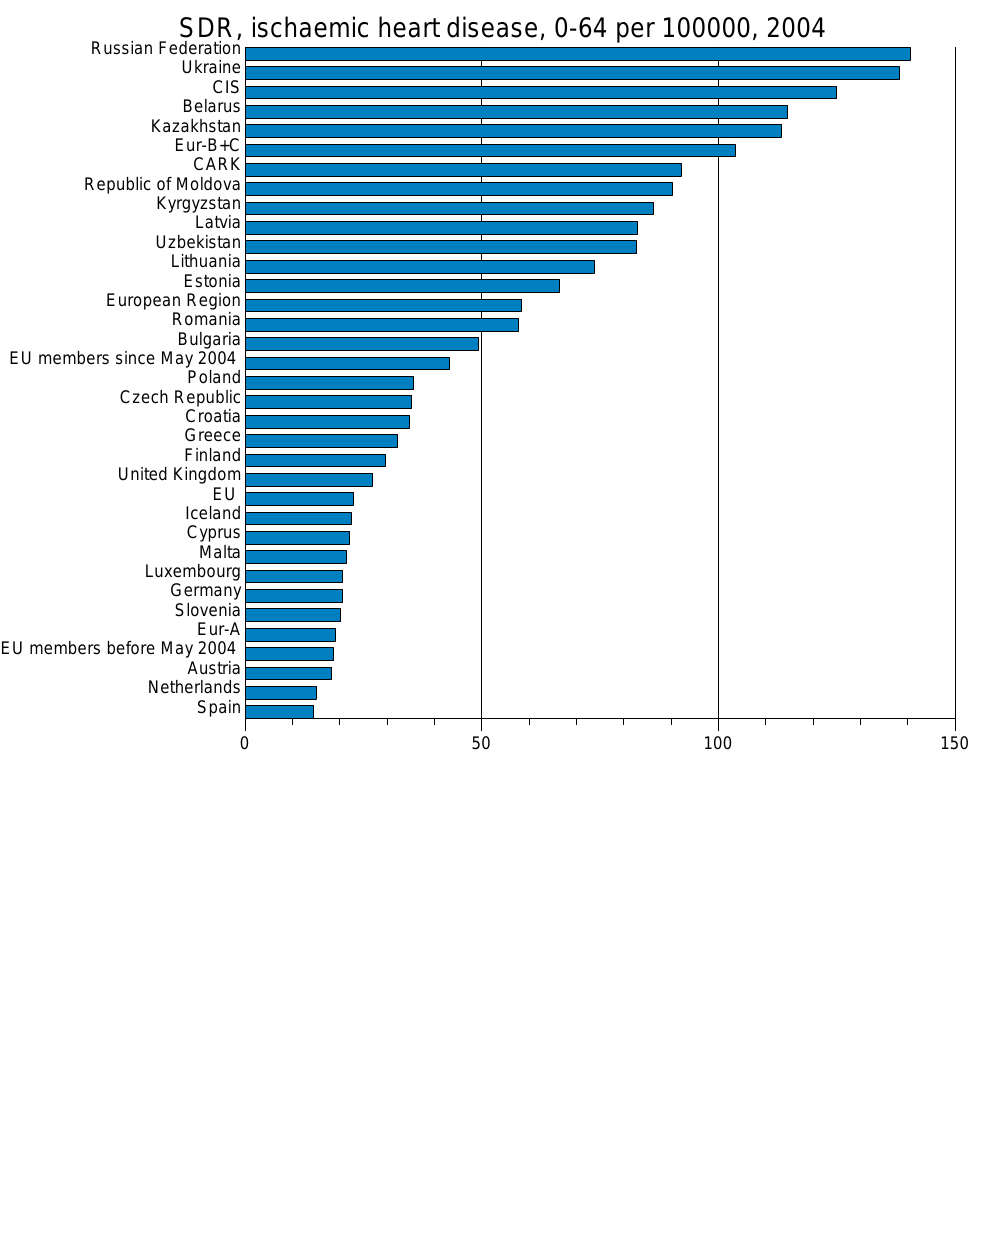
Figure 4: Standardized death rate from coronary heart diseases (per 100,000 population, WHO,